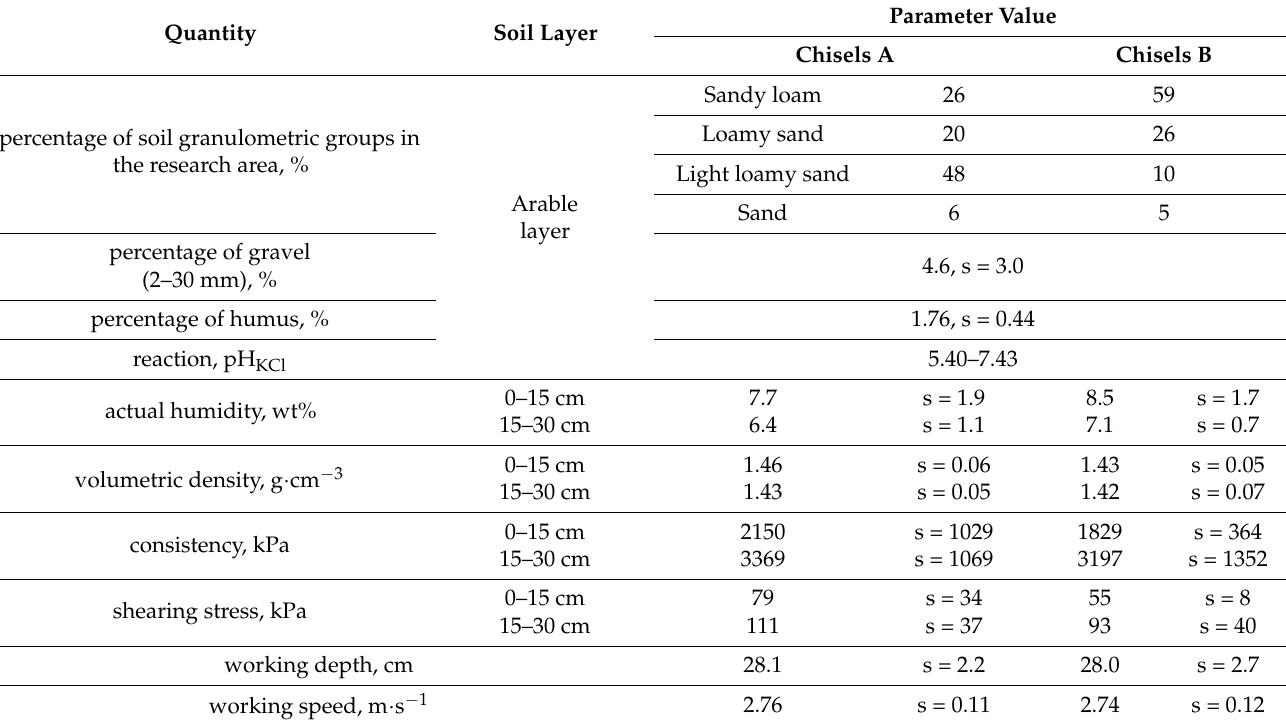
Table 1. Working conditions of examined elements.